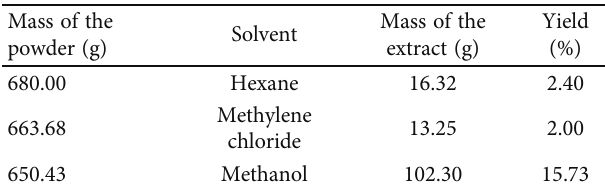
Table 1: Extraction yield of Indigofera tinctoria leaves obtained using solvents of increasing